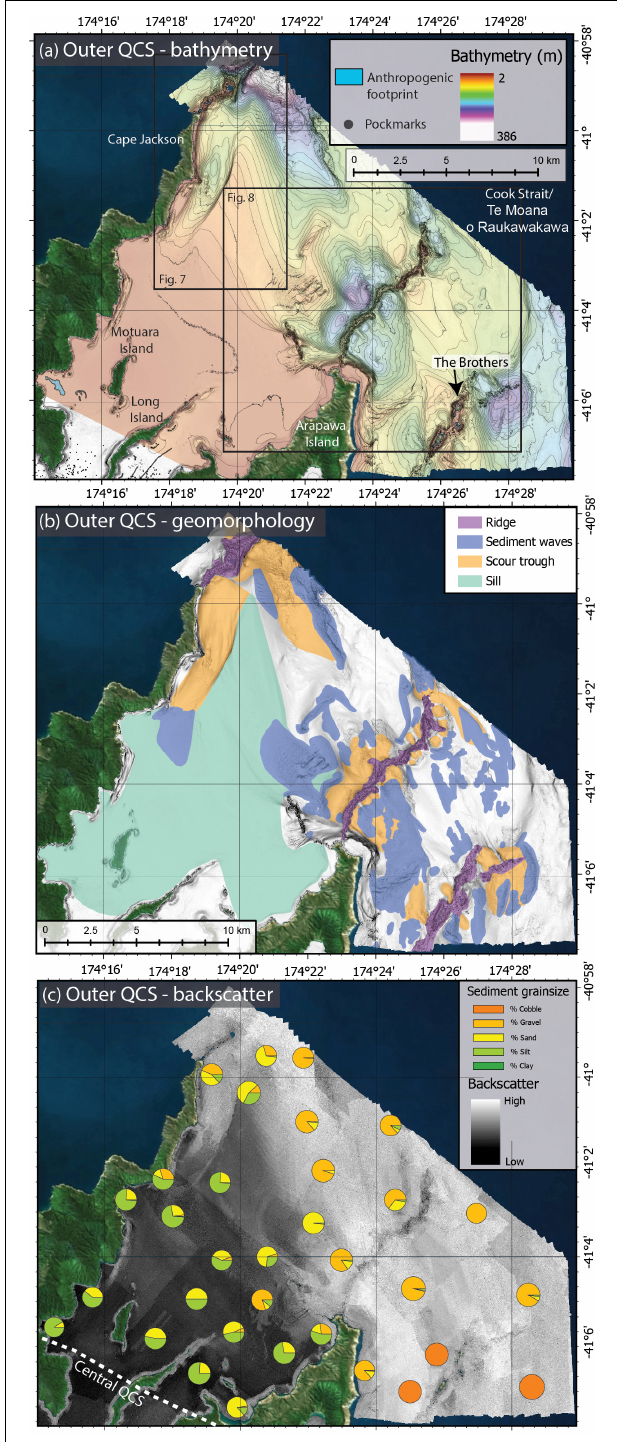
FIGURE 6 | (a) Gridded 2-m bathymetry overview of the outer QCS. For location of outer QCS see Figure 1b . Features described in the main text are labeled. Blue transparent polygons are regions affected by anthropogenic activities, black points are locations of pockmarks, black lines are bathymetric contours at 10 m intervals. Black rectangles show locations of Figures 7 , 8 ( Figure 9B - Profile C-C’ and D-D’): (1) large asymmetrical (Continued) dunes ( ∼ 100 m wavelengths and 15 m amplitudes),